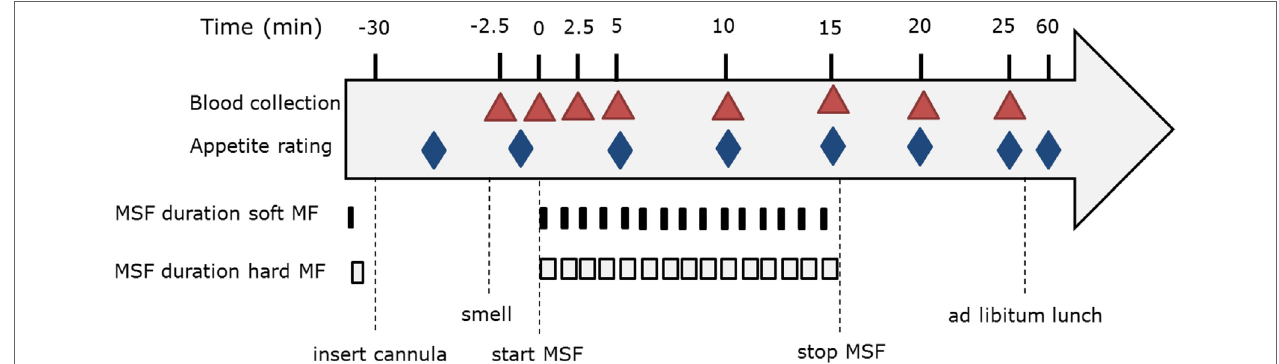
FigUre 3 | Modified sham feeding (MSF) procedure overview including blood sample collection and appetite